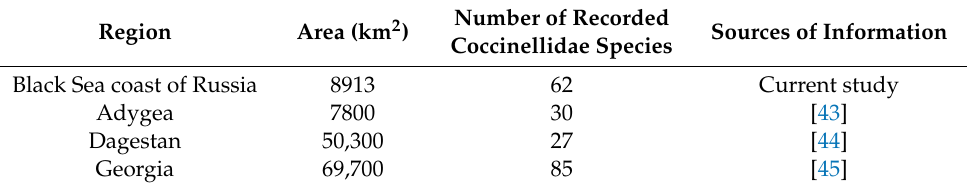
Table 5. Biodiversity of Coccinellidae in some regions of the